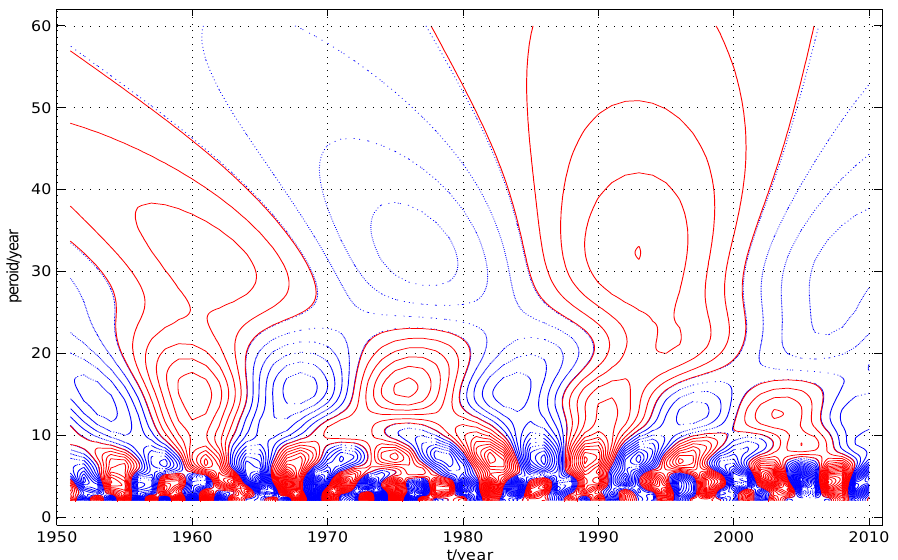
Figure 3. This contour is computed by using Algorithm 2 with the Morlet wavelet parameter σ 2 = 1, η = 5 for Data 2.